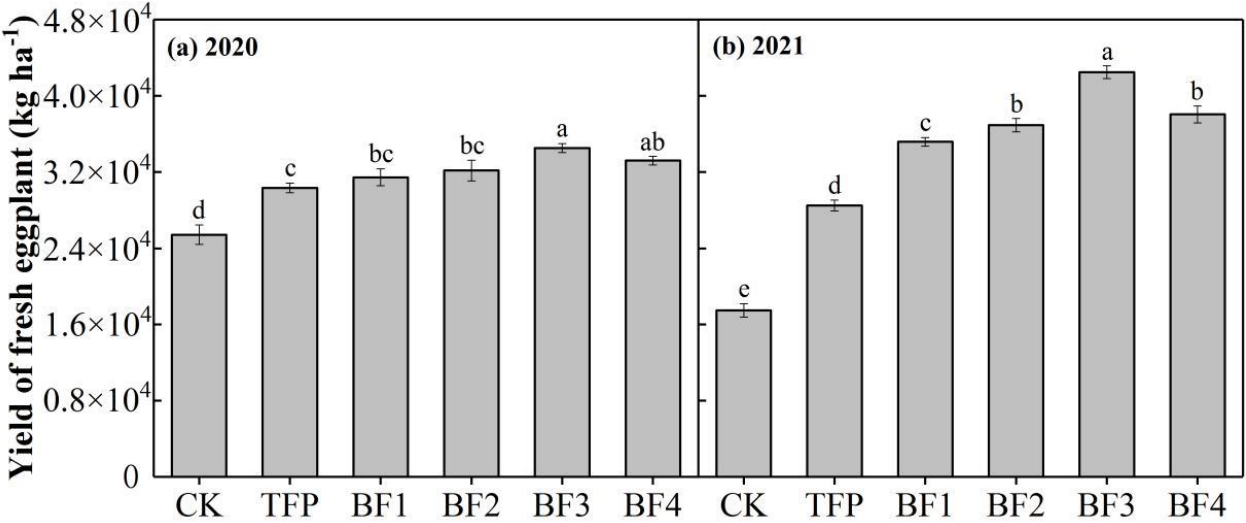
Figure 1. Effects of BF on the yield of fresh eggplant in 2020 ( a ) and 2021 ( b ). CK — no fertilizer; TFP — traditional fertilization practice; BF1 — 1875 kg ha −1 of biochar-based fertilizer (BF); BF2 — 2250 kg ha −1 of BF; BF3 — 2625 kg ha −1 of BF; BF4 — 3000 kg ha −1 of BF. Different lowercase letters denote significant differences among treatment means at the α = 0.05 level using Duncan’s MRT method.